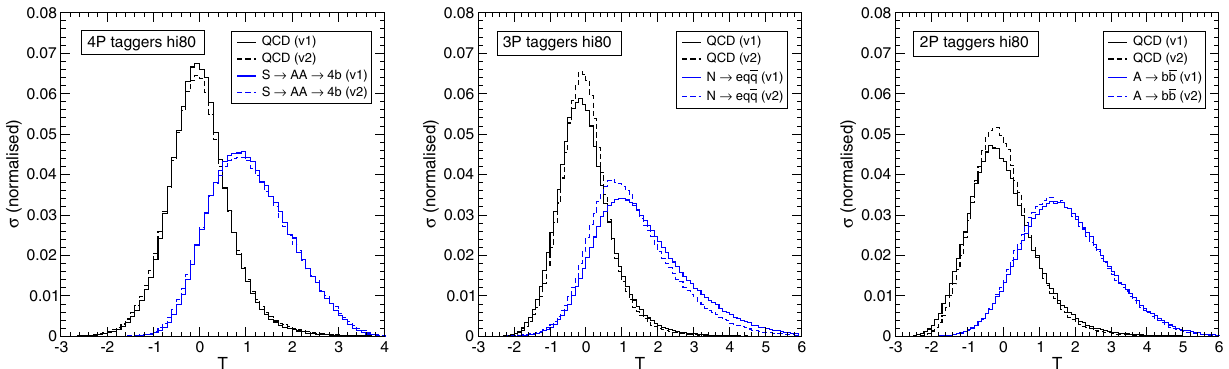
Fig. 2 Distributions of T for the QCD background (black) and selected signals (blue), for the hi80 taggers as in Table 2 (v1, solid lines) and alternate versions (v2, dashed lines) obtained with a different random seed